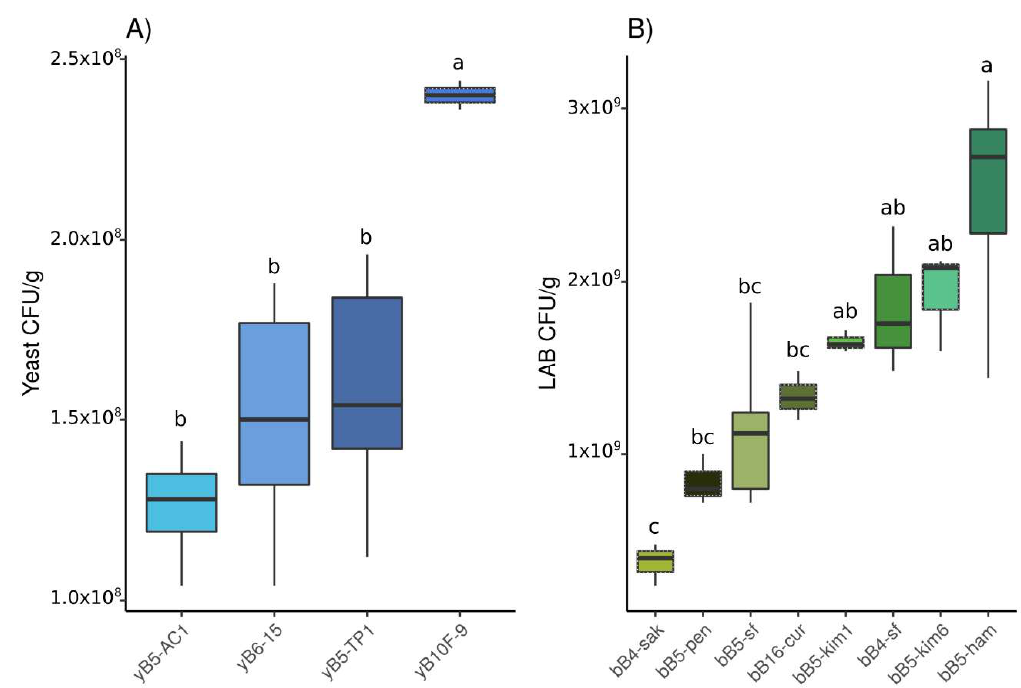
Figure 1. Colony forming units per gram of dough (CFU / g) of ( A ) yeast strains in monoculture and ( B ) LAB strains in monoculture after 24 h. Compact letter display on top indicate Tuckey’s statistical groups. Blue was chosen for yeast strains; dashed lines indicate S. cerevisiae and plain lines K. humilis . Green was chosen for LAB strains, with obligately heterofermentative LAB in plain lines boxplots.